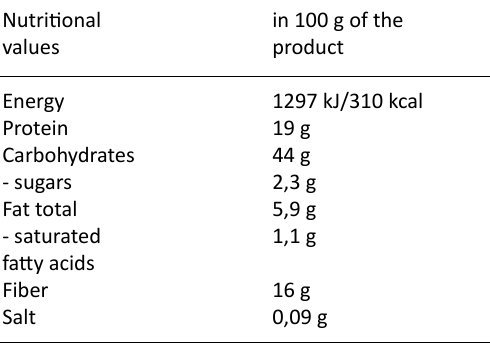
Table 1. Specification of the raw plant material according to the manufacturer’s declaration (Symbio, Poland